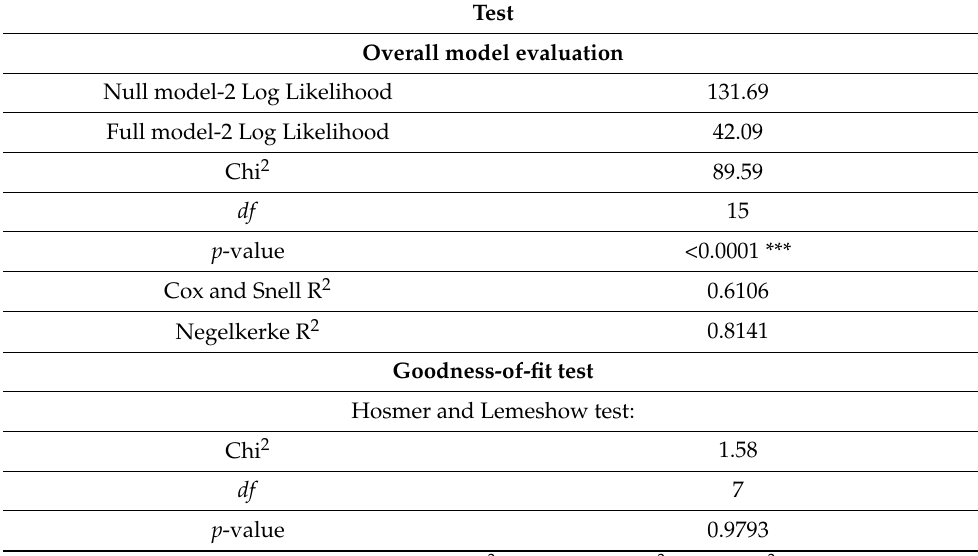
Table 7. The overall performance of multivariable logistic regression